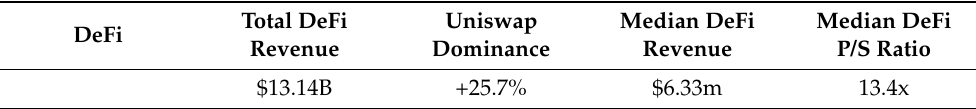
Table 5. Descriptive statistics for the DeFi class of tokens. Total DeFi DeFi Revenue